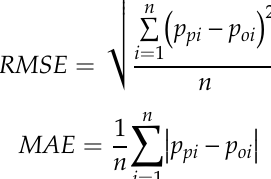
Figure 9. Particle radius distribution of pebbles.